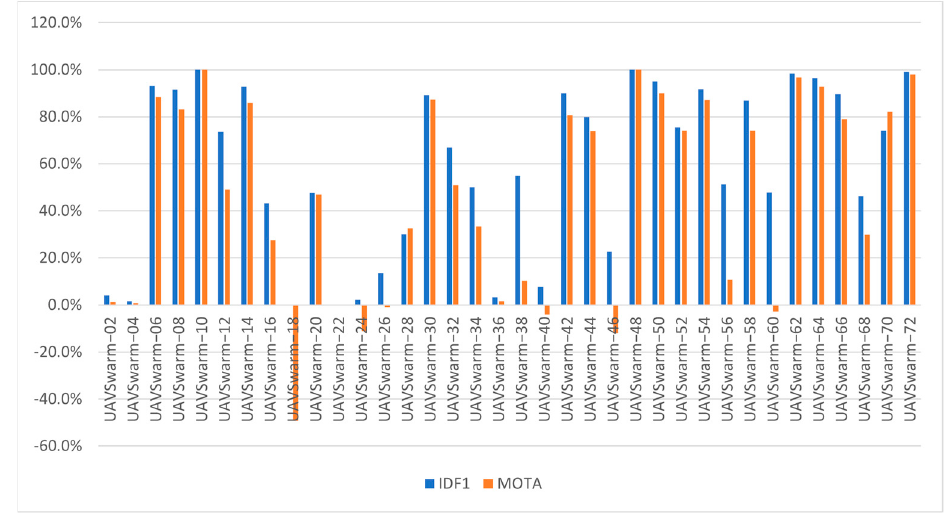
Figure 8. Comparison of IDF1 and MOTA results on the UAVSwarm dataset testing set using ByteTrack.